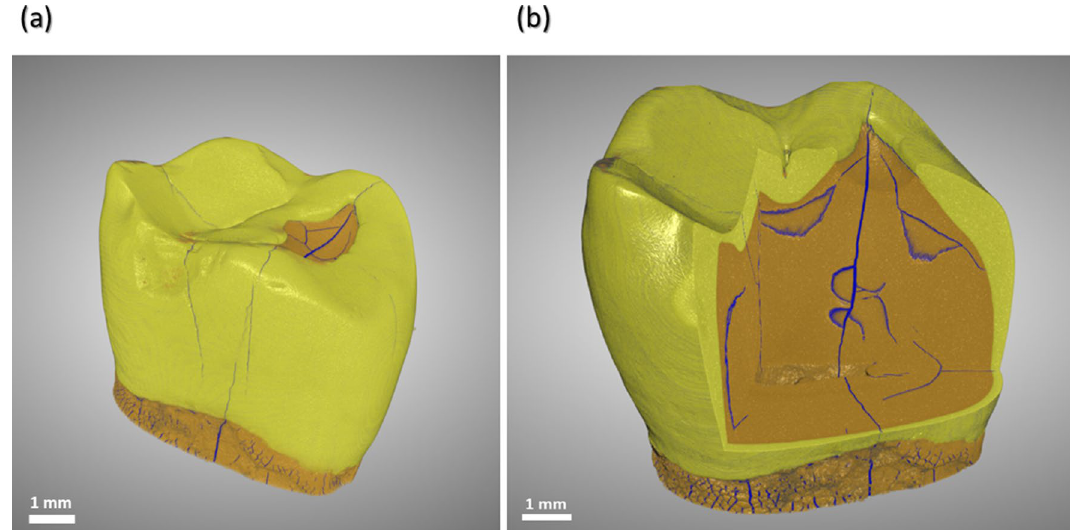
Figure 4. Scanned image ( a ) of the entire tooth using X-ray µ CT and ( b ) a 3D virtual cut through a segmented tooth showing cracks (blue) inside the enamel (yellow) and the dentin (brown; see Supplementary Video S1).